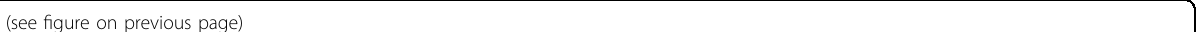
Fig. 2 Differential proportional analysis reveals signi fi cantly expanded or contracted cell lineages associated with the progression of TAAD. a Visualization of cellular density reveals dramatic changes in proportion for smooth muscle cells and macrophages in BAPN vs CTRL. b The proportion of cells from each sample in each cluster. c The relative proportion of each lineage at each stage. Square root transformation was performed on the y -axis. d The relative proportion of each cluster at each time point. In a and b , cells are randomly sampled for equal numbers in each sample ( n = 7316). In c and d , a DPA test was performed. * P < 0.05, ** P < 0.01; CTRL, control; EDO, endothelial cell; FB, fi broblast; MAC, macrophage; PCD, pericardial cell; SMC, smooth muscle